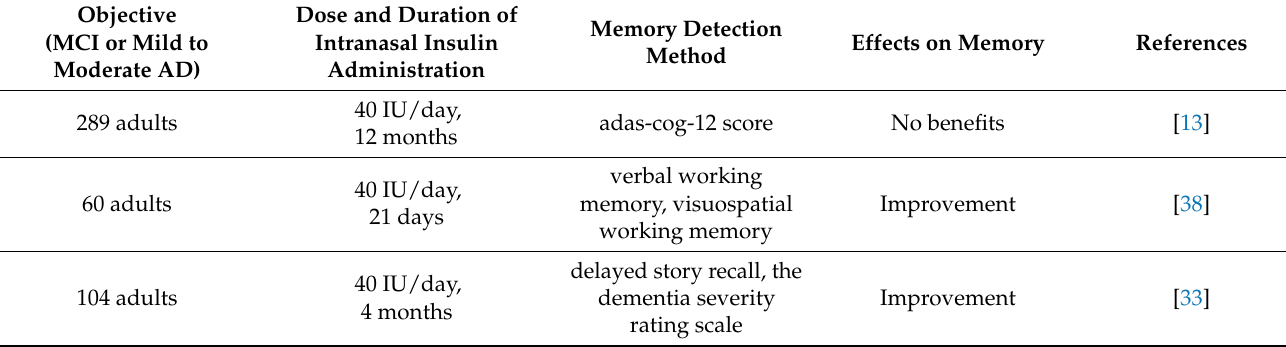
Table 2. Evidence in human